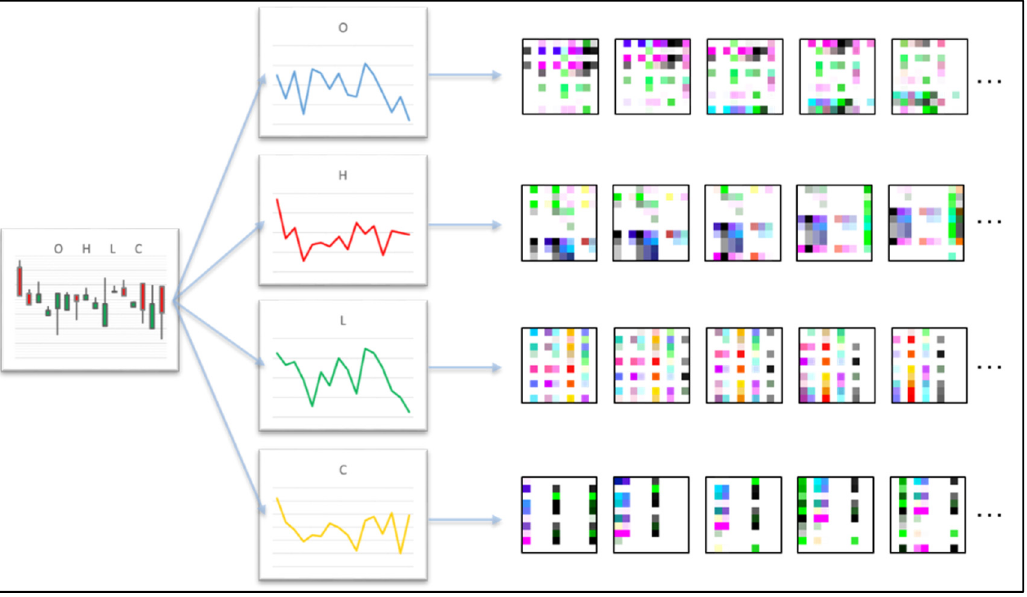
Figure 4. Candlesticks of OHLC time series encoded by GAF into four channels of 10 × 10 images, which are used as input for CNN classifier.